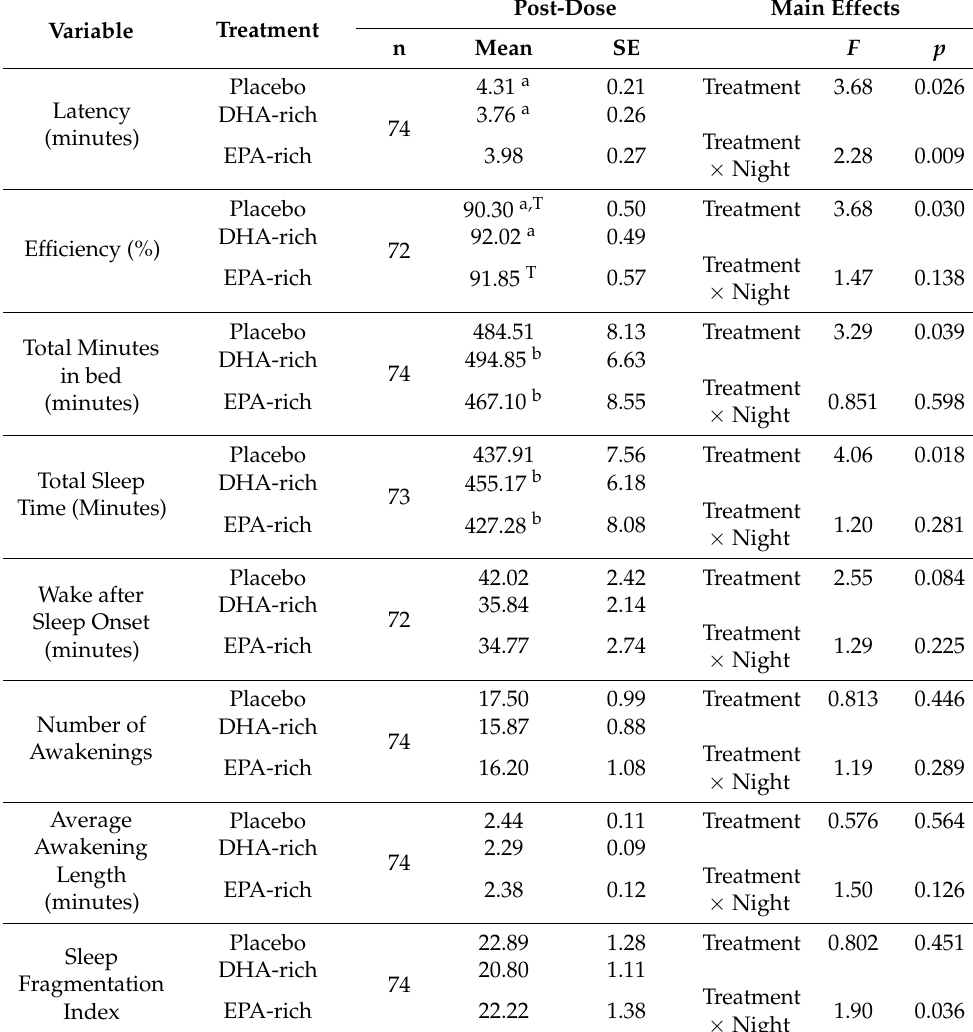
Table 4. Objective sleep outcomes for the placebo, DHA-rich, and EPA-rich treatment groups. Post- dose estimated marginal means and standard error (SE) are presented with F and p values of the main effects from the linear mixed